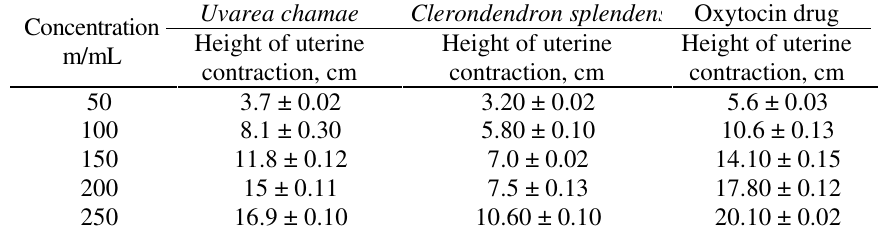
Table 3. Effects of Uaerea chamae, Clerodendron splendens and oxytocin on the uterus of Guinea Pig. Uvarea chamae